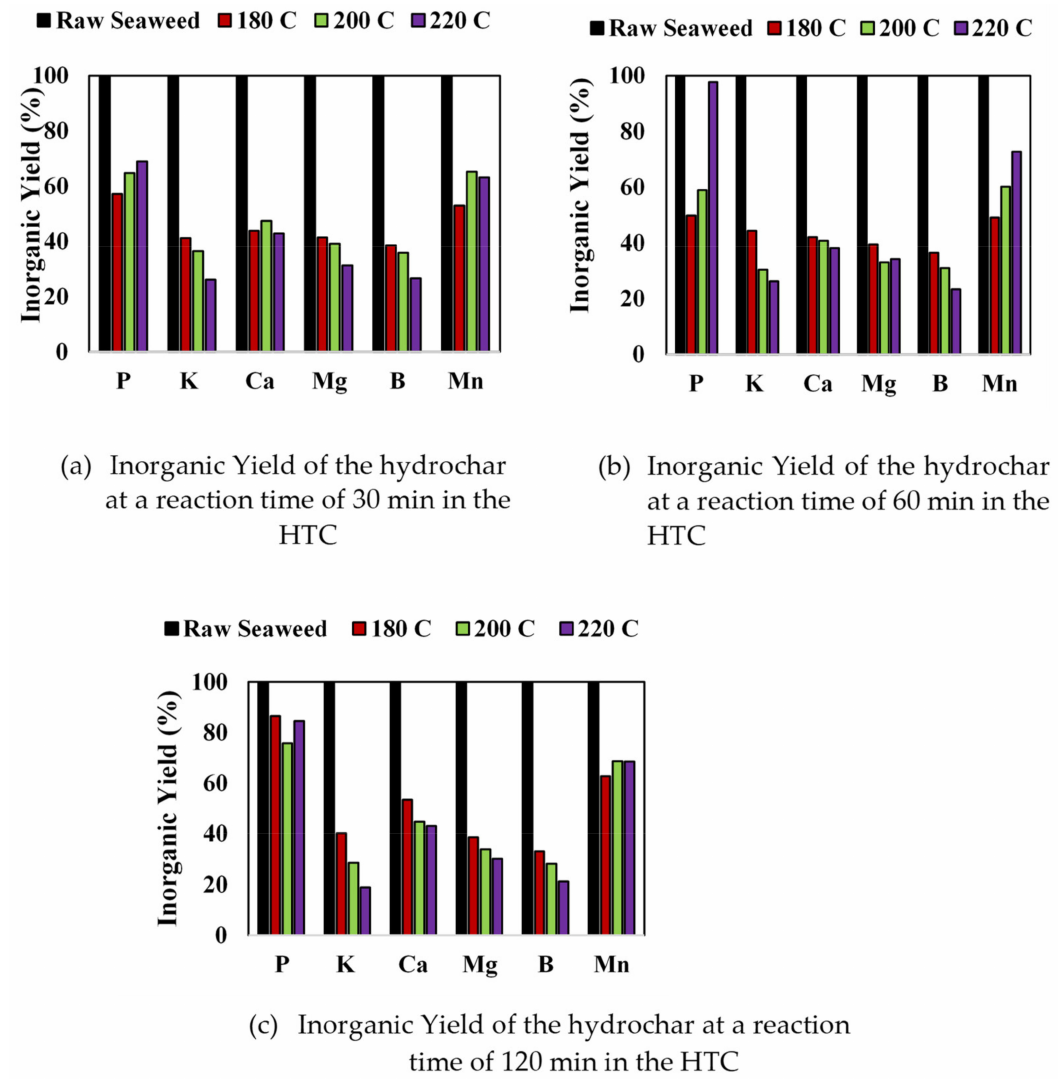
Figure 10. Effect of the process conditions on the inorganic yield of the hydrochar in HTC. Table 4. The concentration of inorganics in the ash of raw seaweed and